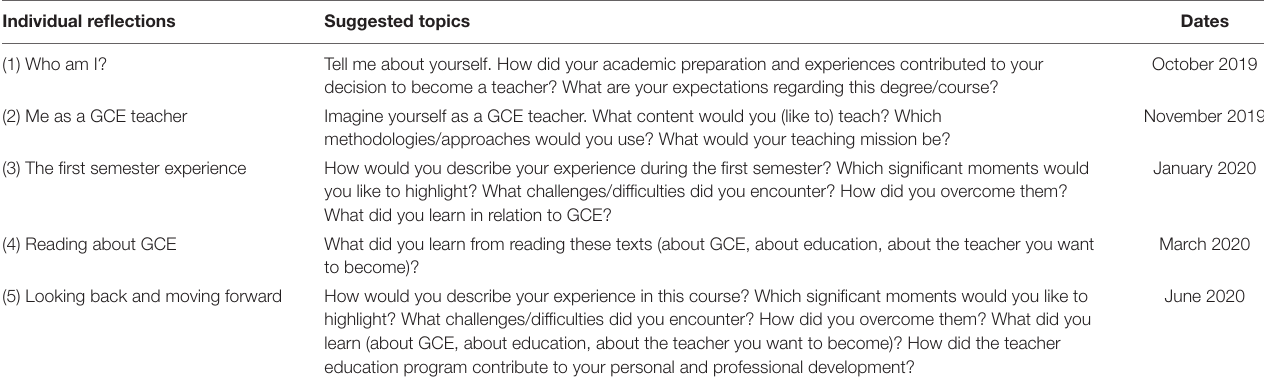
TABLE 1 | Suggested topics and dates for pre-service teachers’ individual reflections. Individual reflections Suggested